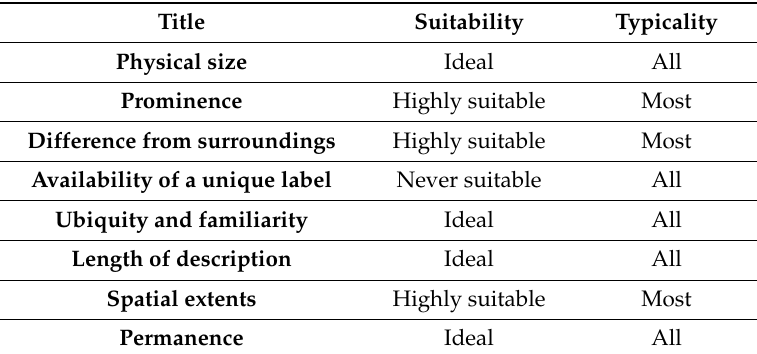
Table 1. Example ratings for the feature category “door”.